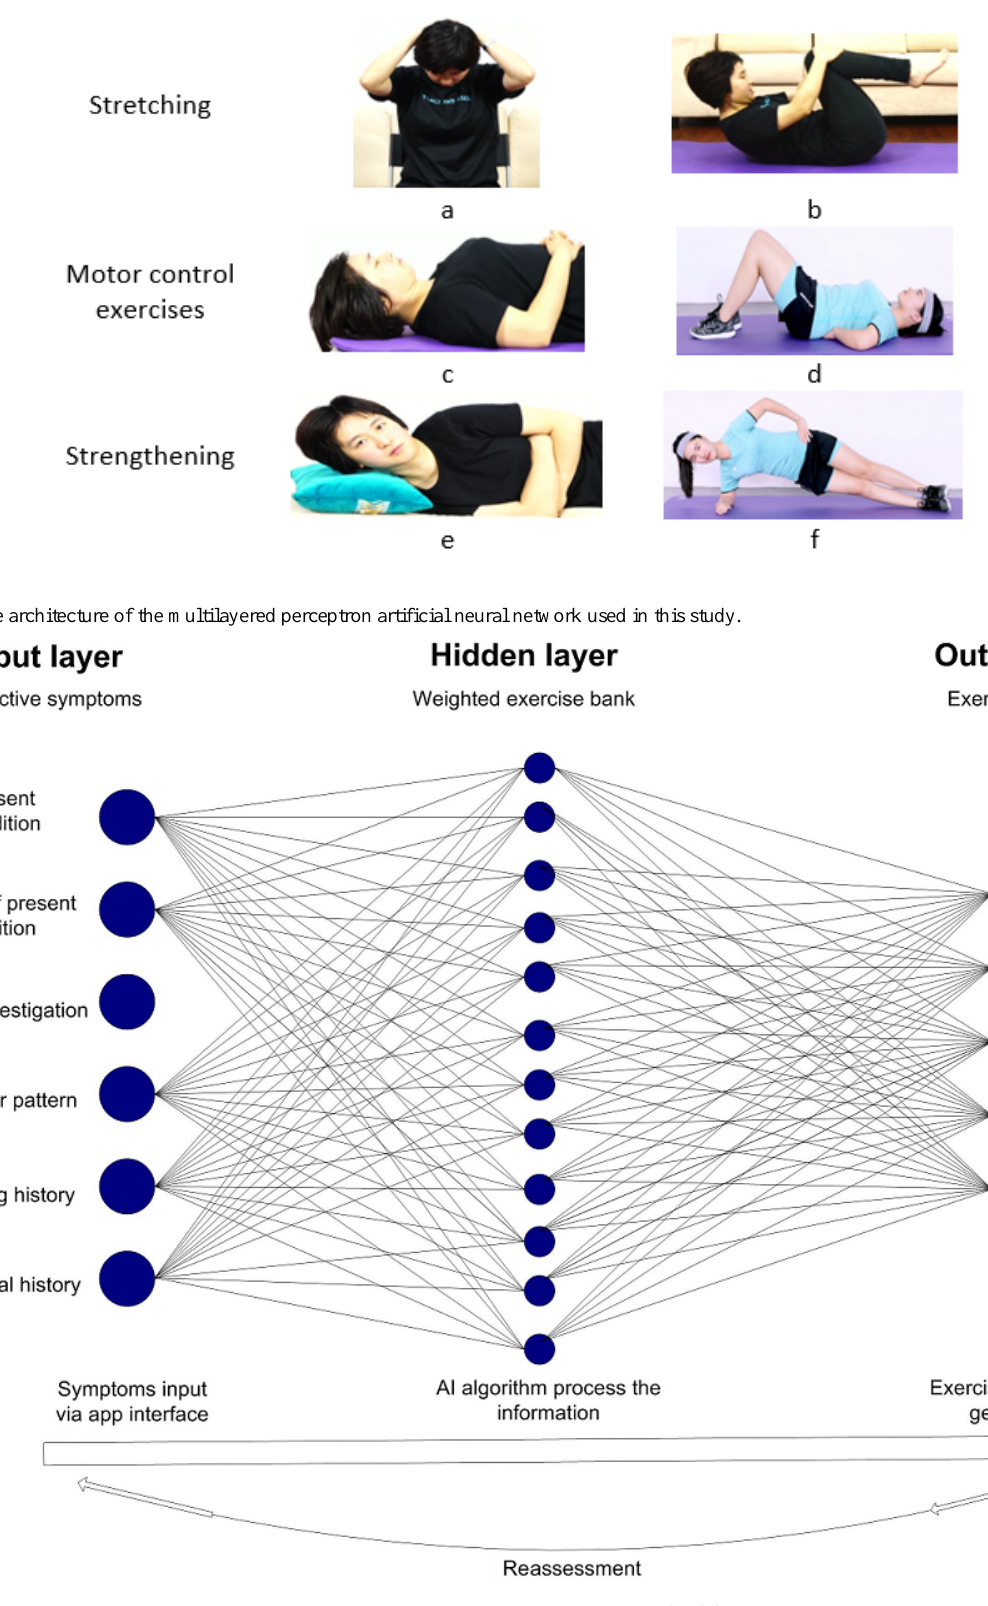
Figure 1. Screenshots of stretching, motor control, and strengthening exercises: (a) assisted neck flexion stretch, (b) lumbar flexion stretch, (c) deep